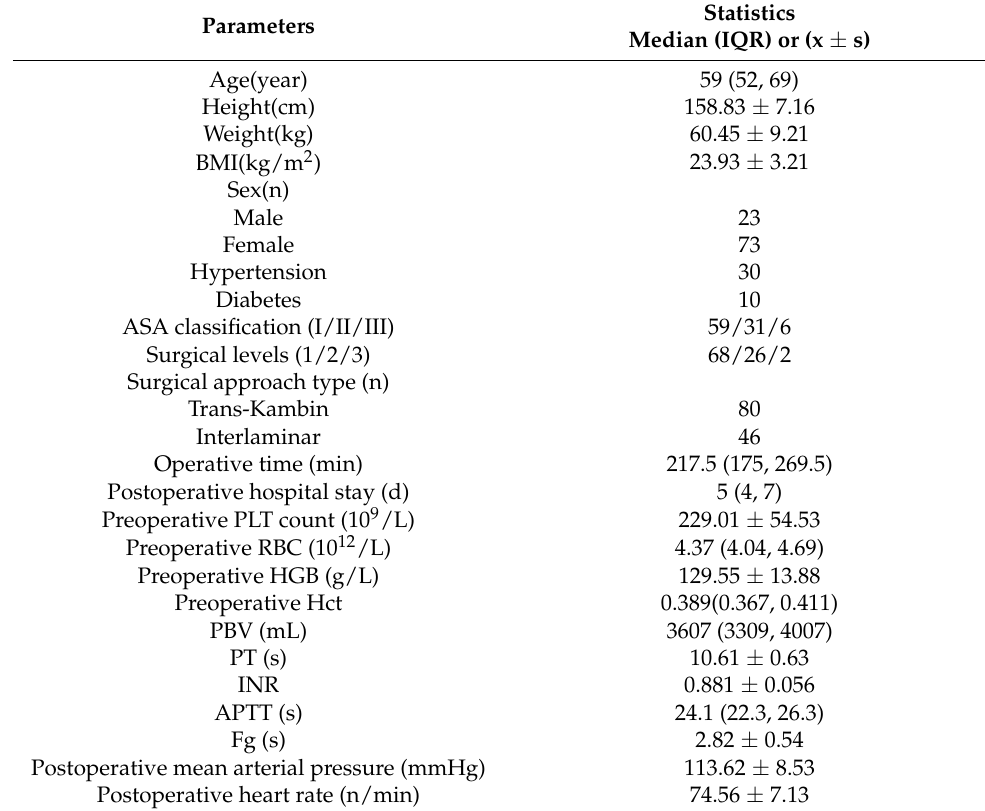
Table 1. Statistical analysis of the demographic parameters.